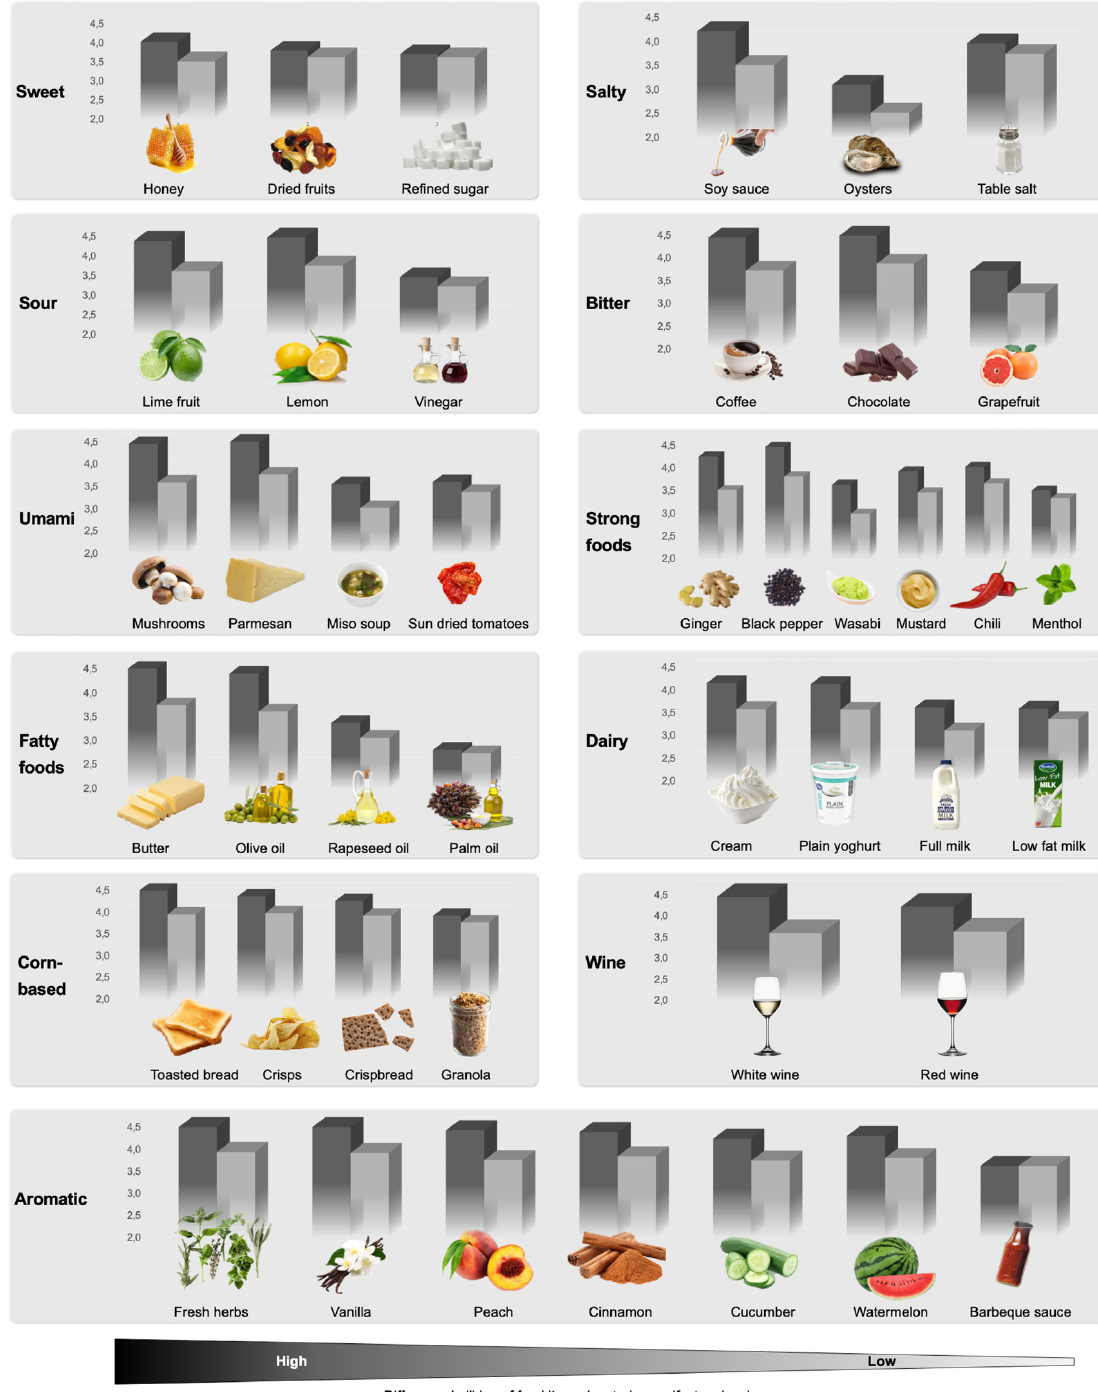
Figure 4. Liking of food items in olfactory loss (grey) compared with normosmic controls (black). For all food items categories (basic tastes, fatty, dairy, corn-based, wine, and aromatic foods) food items are listed from left to right according to the difference in liking between normosmic controls and participants with olfactory loss (high to low difference). When choosing ingredients, food items on the right side of each category are more similar in liking between participants with olfactory loss and normosmic controls. This may indicate ‘safer foods’, however, please see Table 3, as some items are rated lower in the frequency of intake, which may influence ratings of liking.